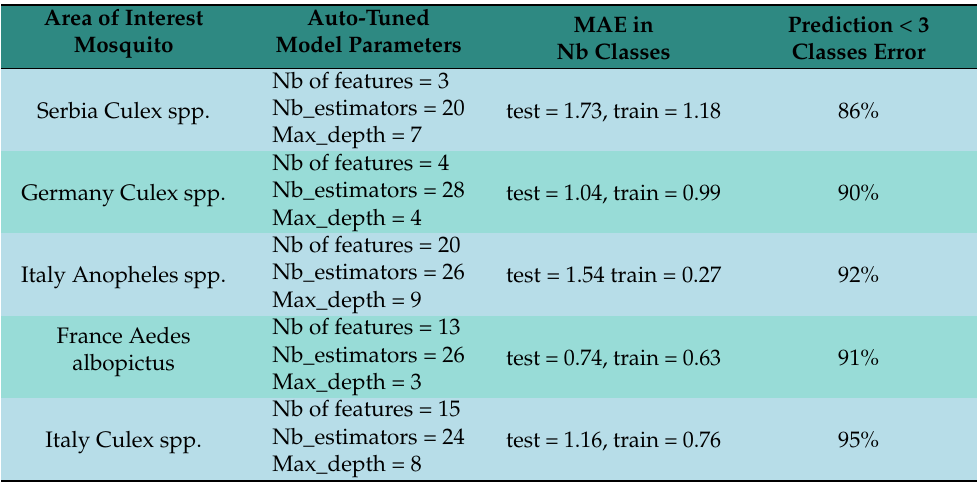
Table A3. MAMOTH’s pre-operational applications and performance per country without using any EO features.